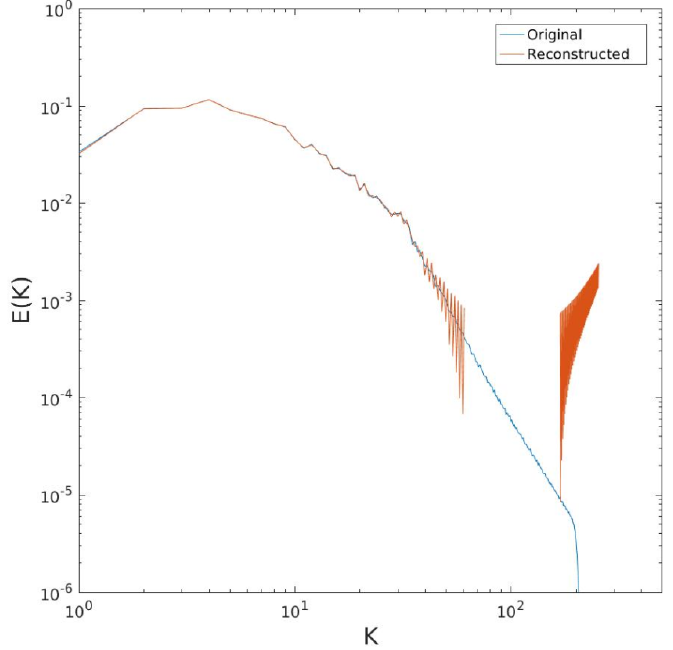
Figure 6. Kinetic energy spectrum from the turbulence simulation with the reconstruction from the structure function based on (15). The structure function was obtained from the spectrum using (14).